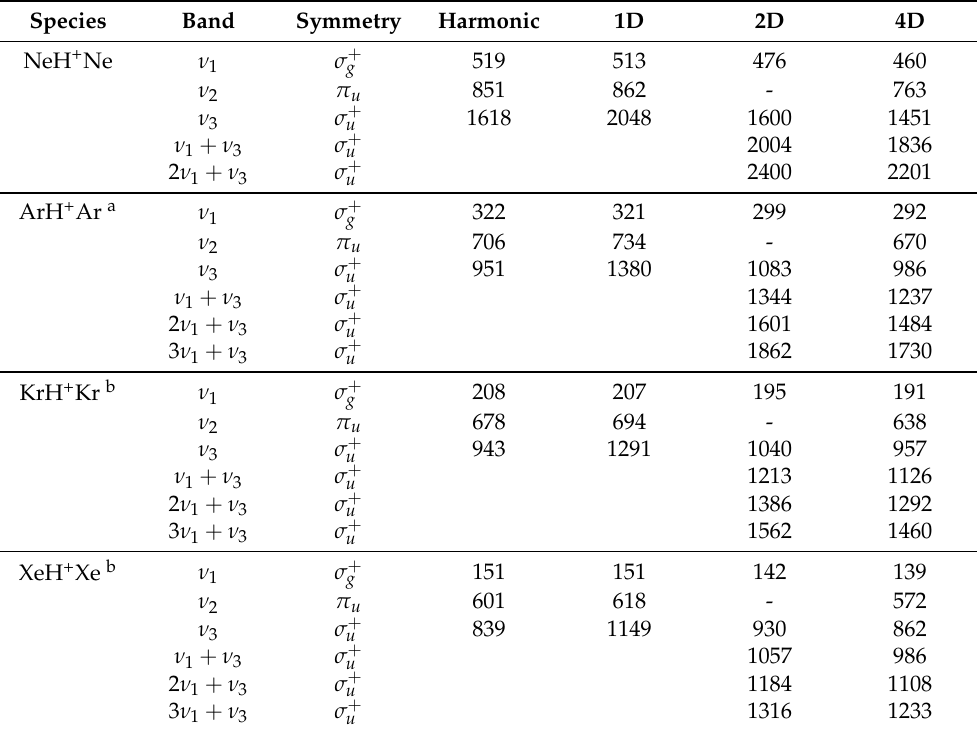
Table 4. Harmonic and anharmonic fundamental frequencies for NgH + Ng.